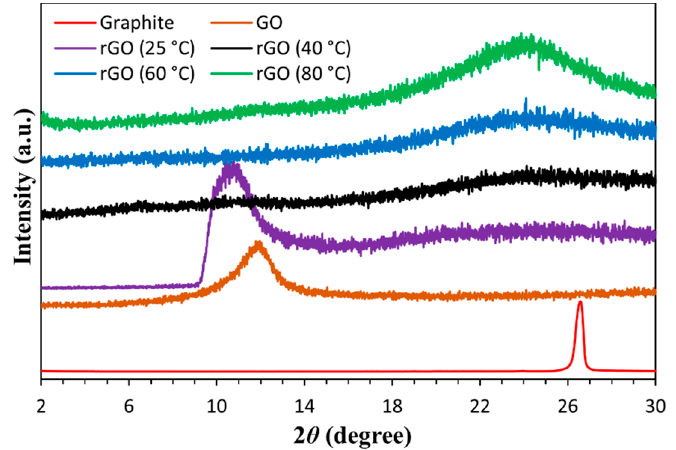
Figure 5. XRD patterns of graphite powder, GO and rGO synthesized using lemon juice at different